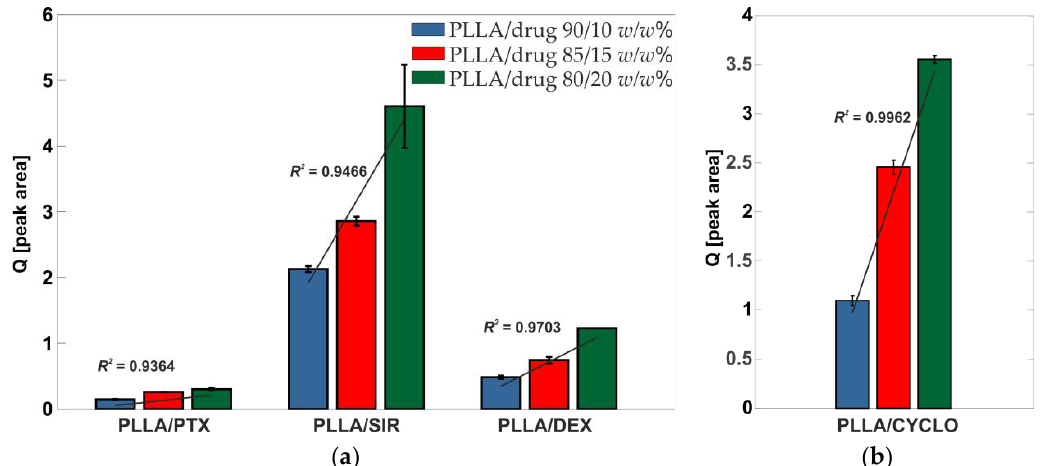
Figure 1. ( a ) Quotients of drug signal found in Raman spectroscopy (PTX: 𝜈̃ = 1012 rel cm −1 , SIR: 𝜈̃ = 1642 rel cm −1 , DEX: 𝜈̃ = 1668 rel cm −1 ) compared to PLLA reference signal to ensure drug loading. ( b ) Quotient of the CYCLO signal at 𝜈̃ = 1629 cm −1 from FT-IR spectroscopy compared to PLLA reference signal. Linear regression of the means has been performed and R 2 values are given.